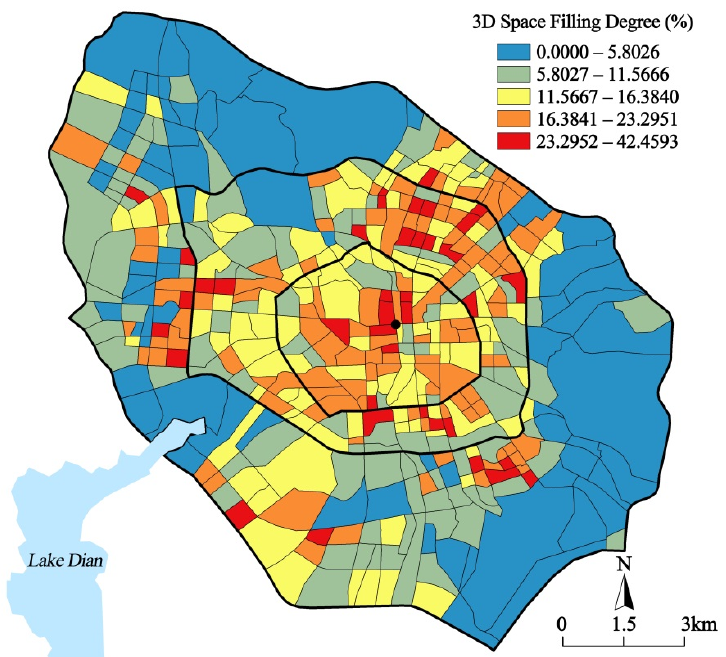
Figure 5. The spatial distribution pattern of 3DSFD in Kunming's Main Urban District using the natural breaks (Jenks) method.